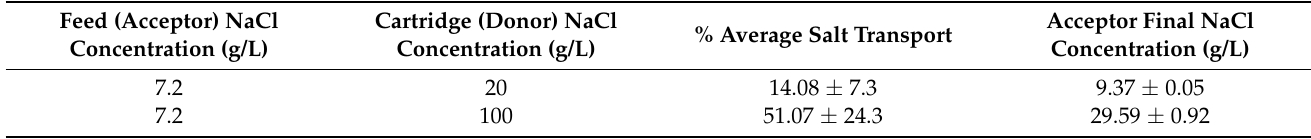
Table 1. Preliminary pick-up tests for function verification * (n =